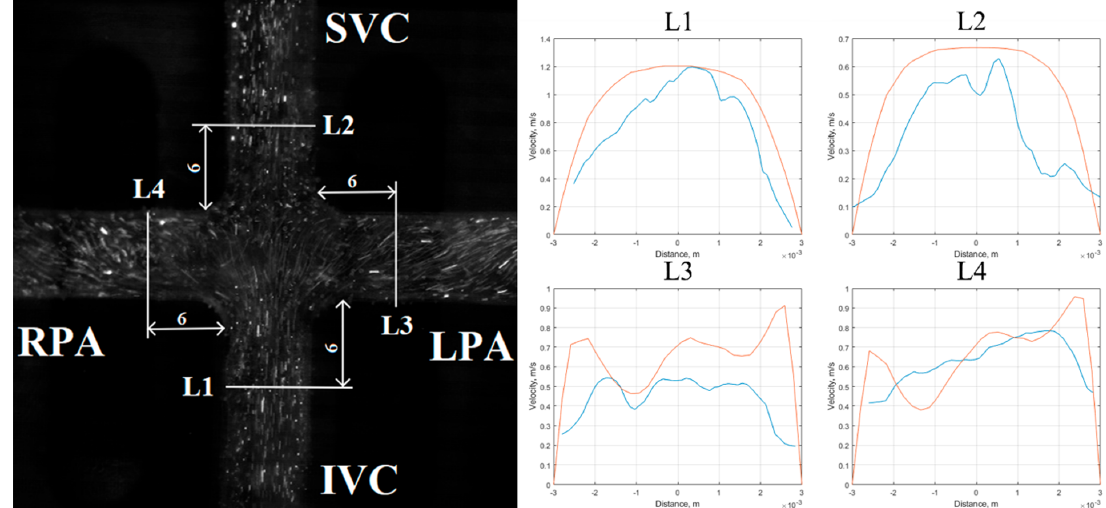
Figure 10. Velocity modulus distribution in various sections for TCPC ‐ 1: red line—CFD modeling, blue line—experimental data. L1, L3, and L4 repeating the curve shape for both methods. In cross ‐ section L2 flow is compressed closer to the center due to the design features of internal cavity of SVC.